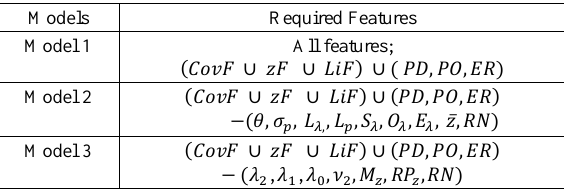
Table 2. Three groups of features; Models 1, 2 and